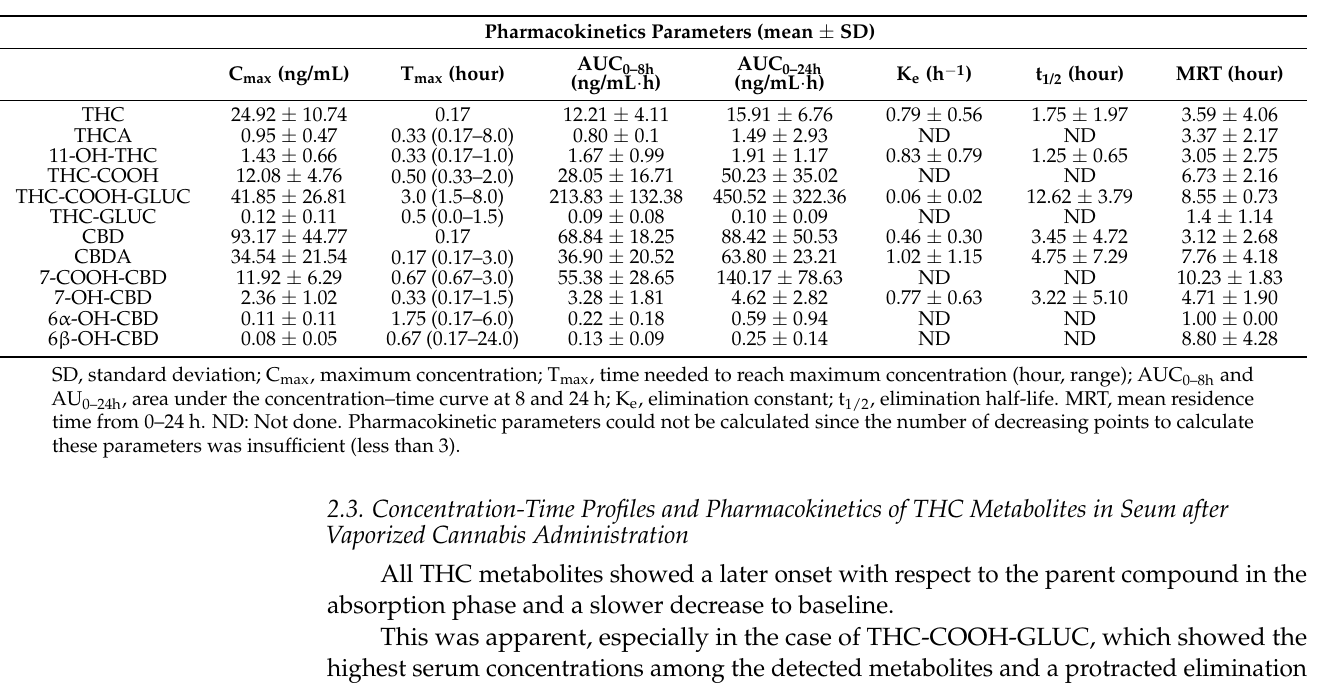
Table 2. Pharmacokinetic parameters of THC, CBD, acidic precursors, and metabolites in serum of healthy volunteers administered with 100 mg vaporized medical